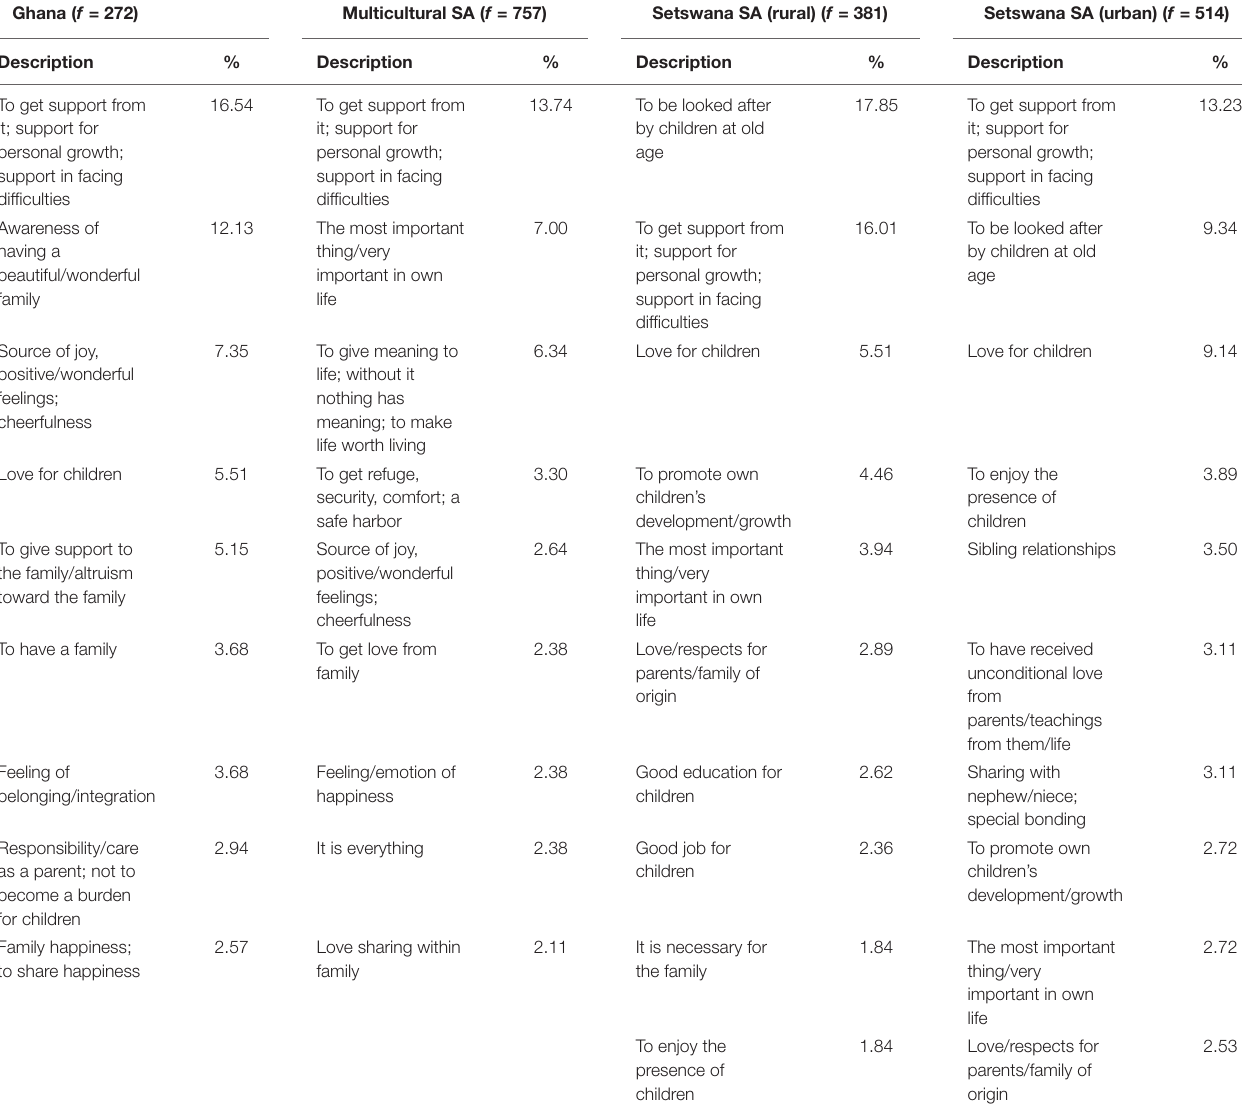
TABLE 4 | Percentages of the most frequent codes in the motivations for meaning sources in the family domain of life. Ghana ( f = 272) Multicultural SA ( f = 757) Setswana SA (rural) ( f = 381) Setswana SA (urban) ( f =